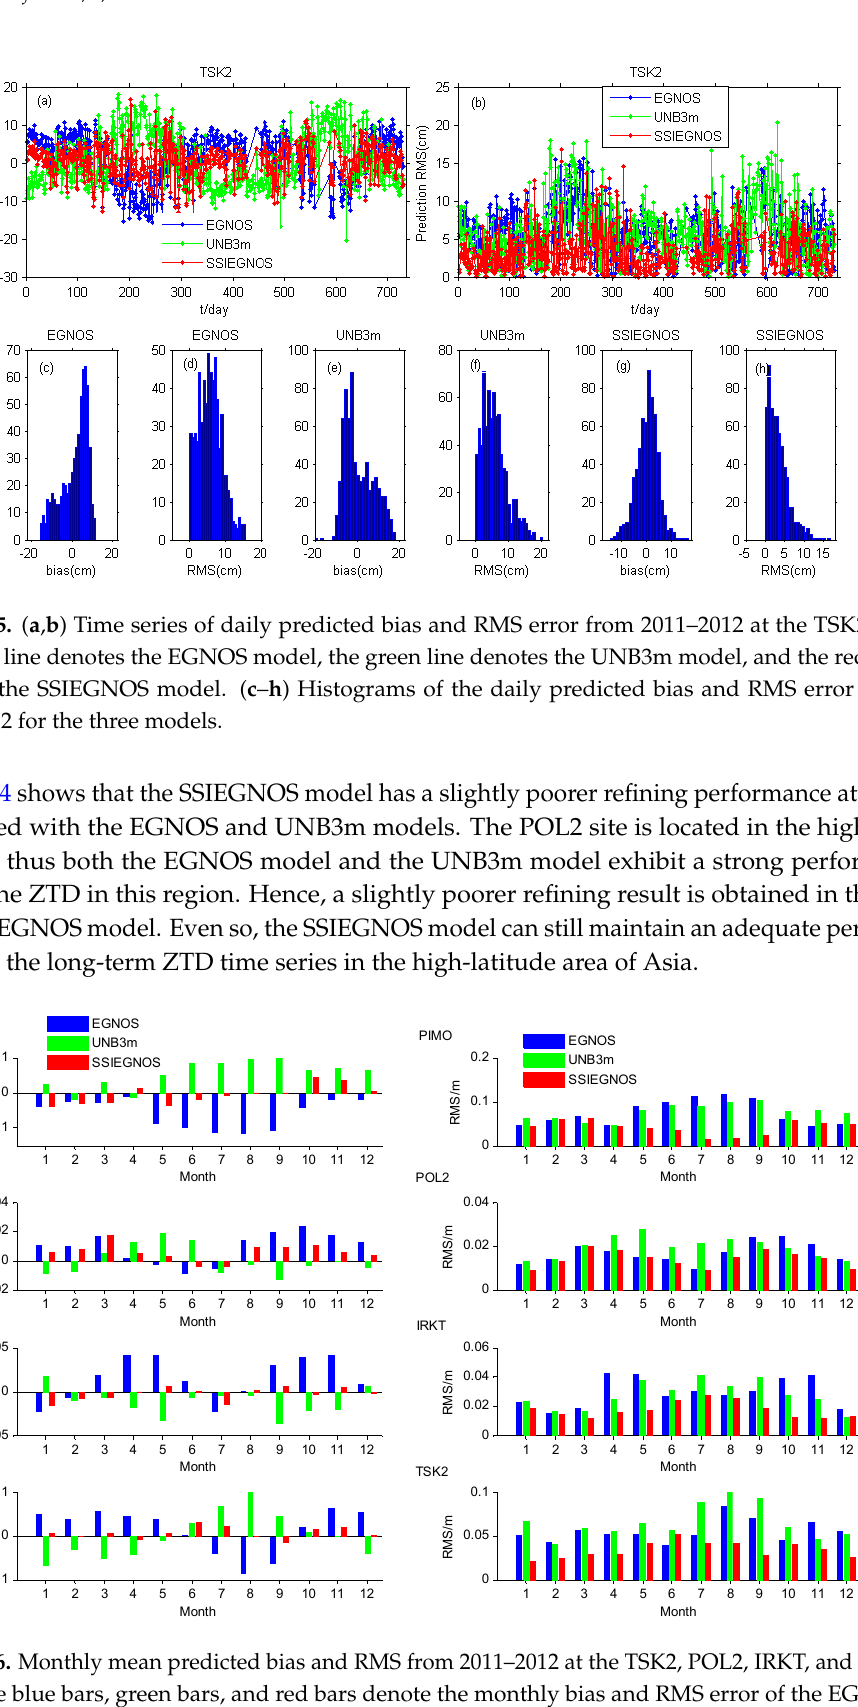
Figure 17. Seasonal mean predicted bias and RMS error from 2011–2012 at the TSK2, POL2, IRKT, and TSK2 sites. The blue bars, green bars and red bars denote the monthly bias and RMS error of the EGNOS, UNB3m, and SSIEGNOS models, respectively. 4. Conclusions In this study, five years of ZTD data from 2008 to 2012 of 46 IGS sites distributed in Asia were used to investigate the performance of the SSIEGNOS model. The results are as follows: